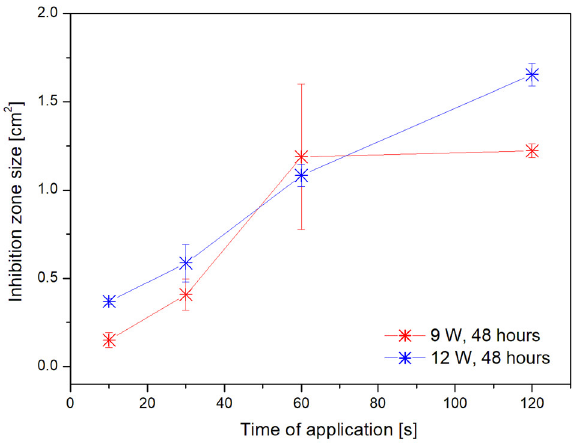
Figure 5. The dependence of the inhibition zone size on the plasma exposure time for the 100-fold dilution. Data after 24 h are missing because the inhibition zone was not clear enough at this stage.